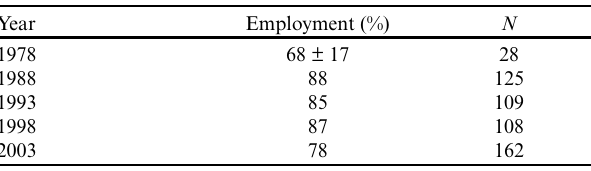
Table 4. Percentage of 16–69-year-old residents of Anaktuvuk Pass with full- or part-time jobs, 1978–2003. Source: North Slope Borough census 1978, 1988, 1993, and 2003 ( unpublished data